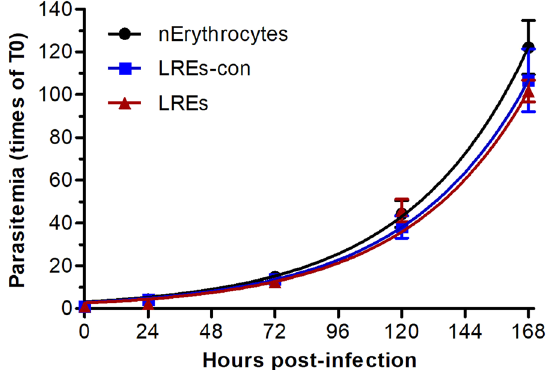
Figure 1. Growth profiles of P . falciparum . Purified trophozoite/schizont stage parasite were added to normal erythrocytes (nErythrocytes), LREs prepared without concentration (LREs) or after concentration (LREs-con) of the lysate. Parasite growth was monitored for 168 hours post-infection and parasitemia is shown as mean with SD from 3 experiments for nErythrocytes, 2 experiments for LREs-con and a single experiment for